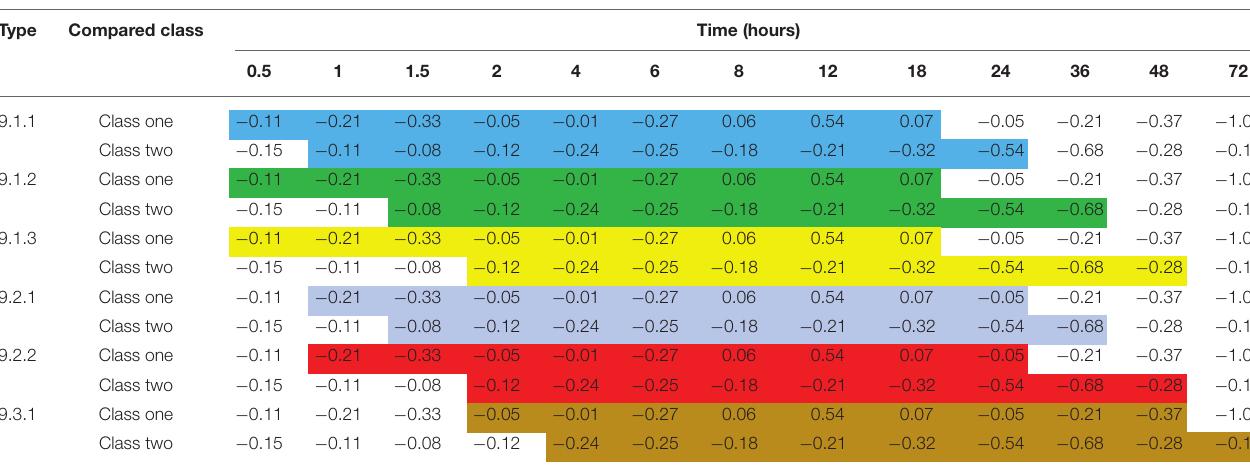
TABLE 2 | Examples of sliding windows with different